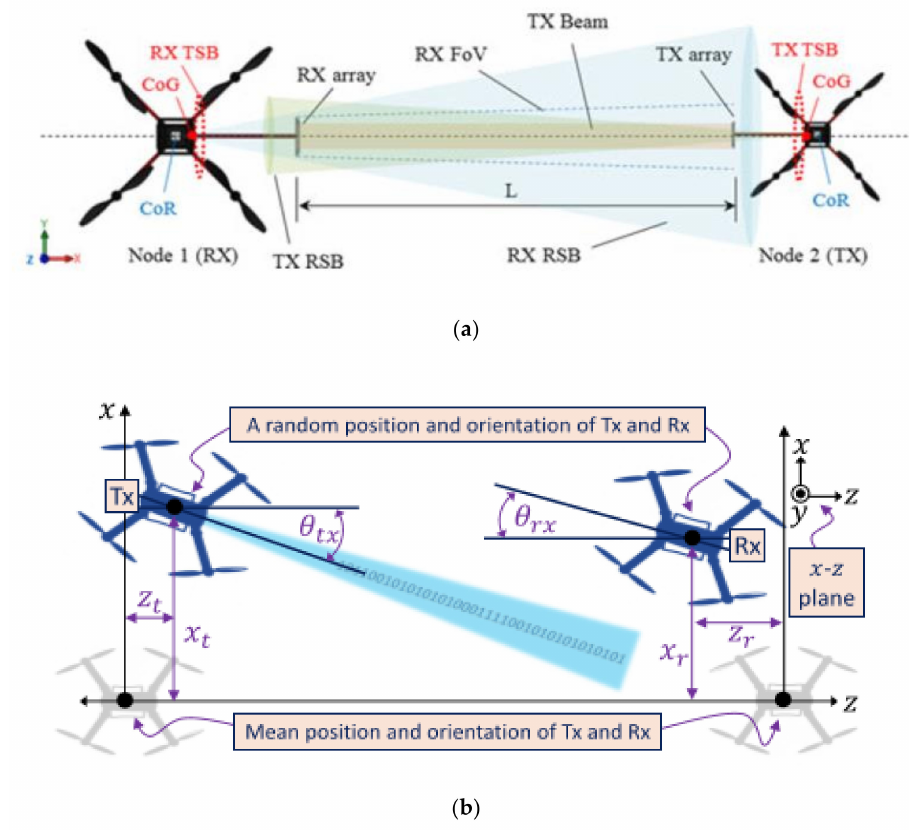
Figure 5. ( a ) A typical A2A free space optical (FSO) link [61] and ( b ) schematic 2D of a UAV–UAV FSO system